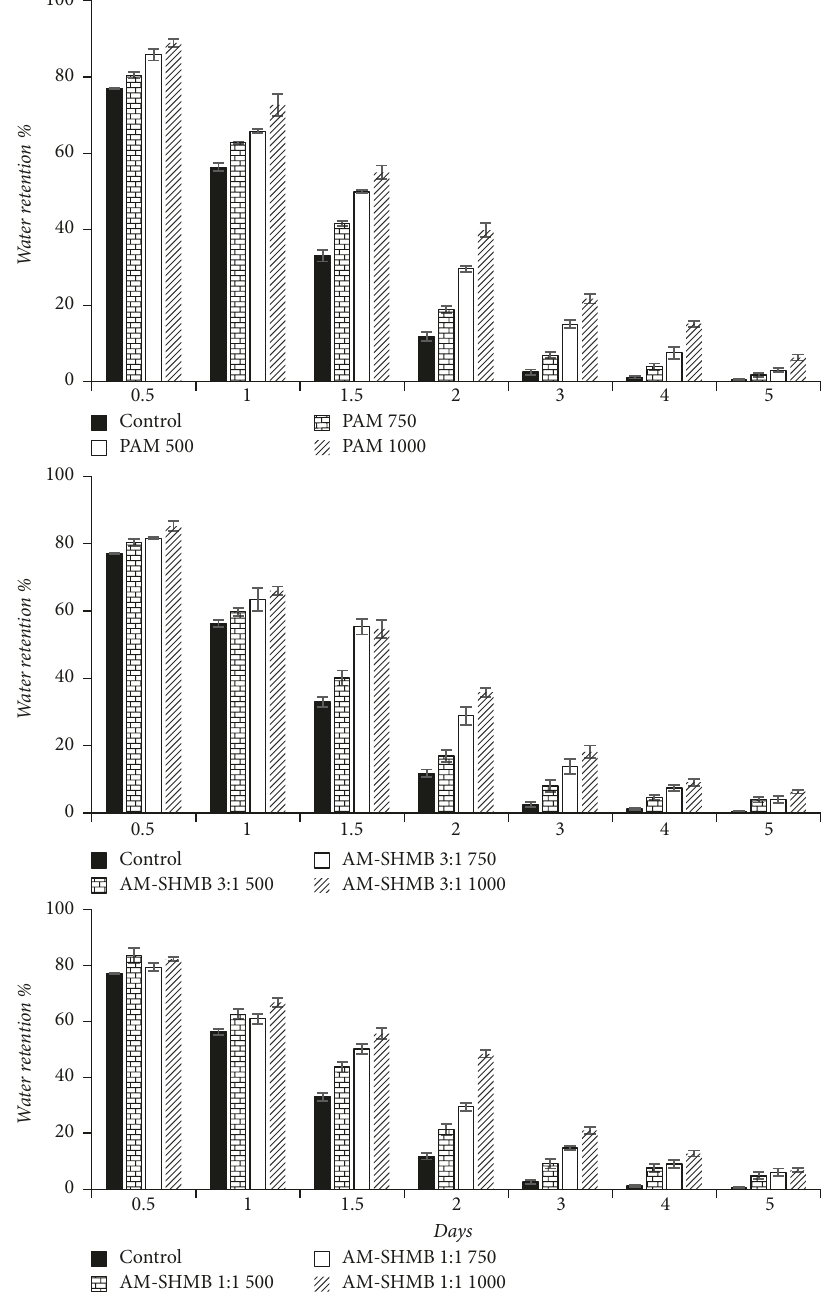
Figure 1: Percentagewater retention for pure soil and soil containing various concentrations of polyacrylamide (PAM) and poly(acrylamide- co -sodium 4-hydroxy-2-methylenebutanoate) (AM-SHMB)